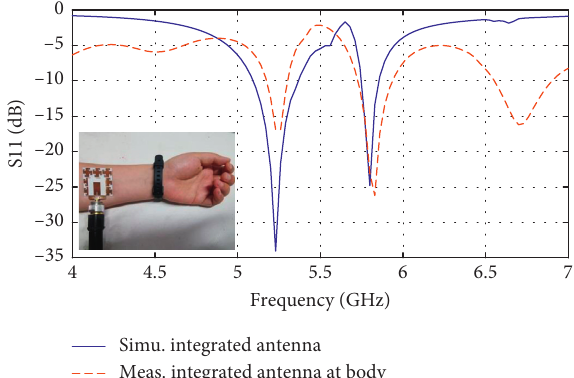
Simu. integrated antenna Meas. integrated antenna at Figure 10: S 11 of the integrated MSs antenna at human